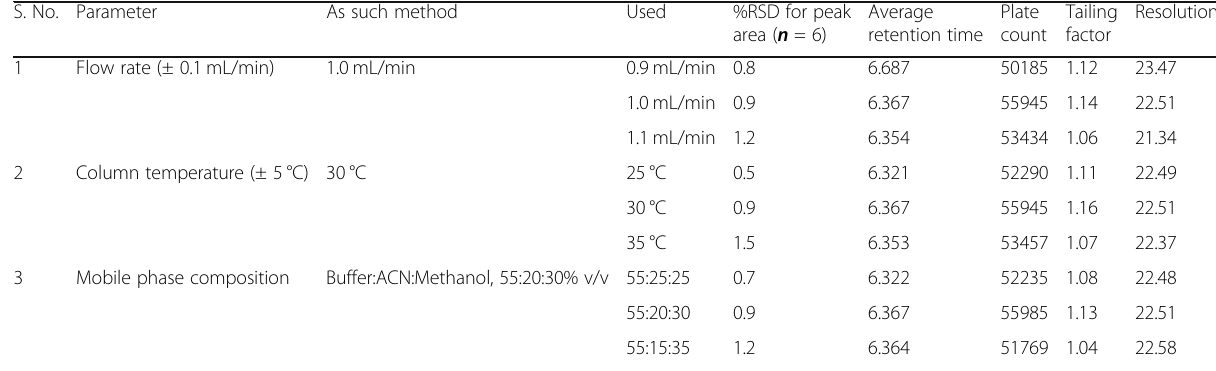
Table 9 Robustness results for dolutegravir S. No. Parameter